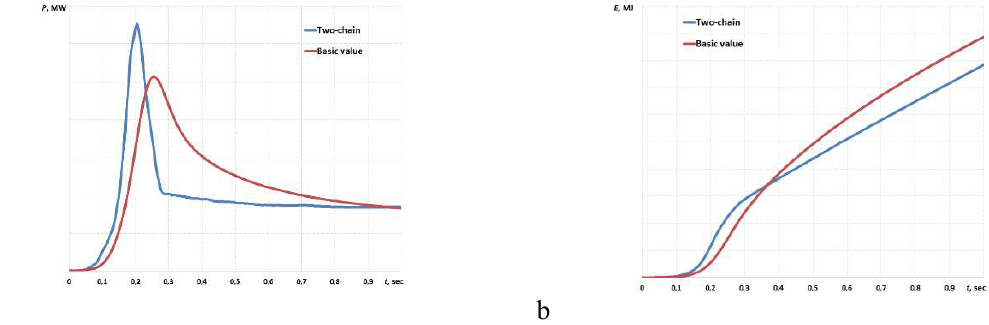
Figure 4: Transient Power (a) and Deposit Energy (b) evolution in the models with a traditional homogenous (red) and a heterogeneous placement of fissile clusters